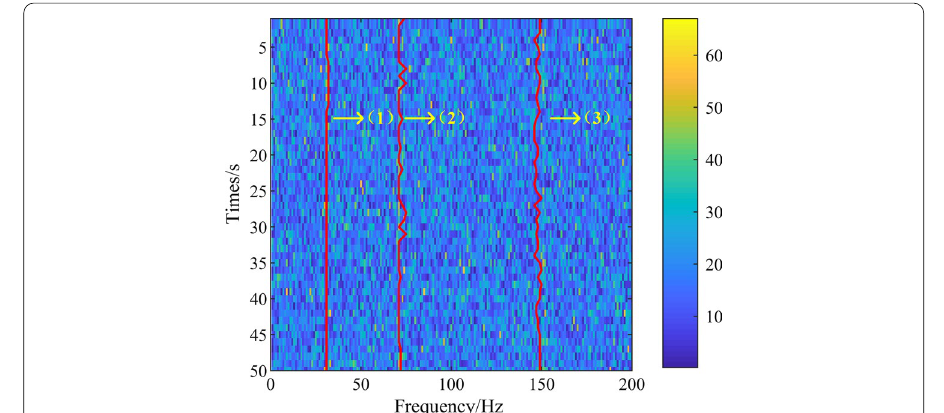
Fig. 11 Line-spectrum-extraction results of optimal path algorithm at